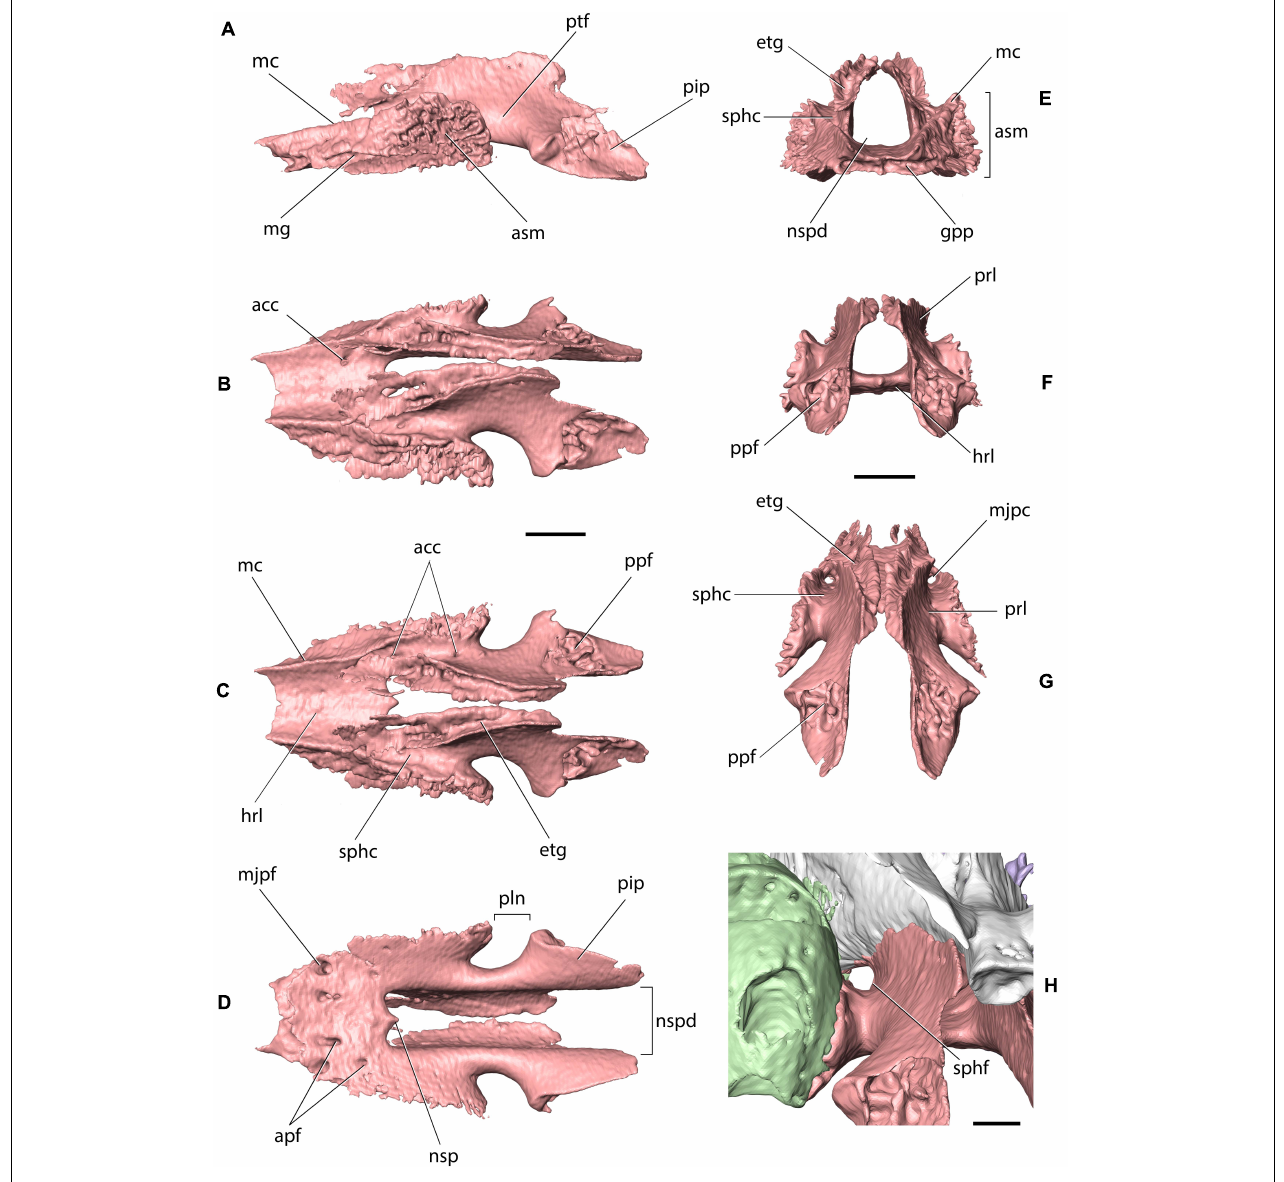
FIGURE 7 | Palatine of Palaeolagus haydeni (FMNH PM9476) in (A) left lateral, (B) left dorsolateral, (C) dorsal, (D ) ventral, (E) anterior, (F) posterior, (G) posterodorsal, and (H) left posterolateral views. Left maxilla shown in light green, presphenoid shown in white. acc, dorsal opening of accessory palatine canal; apf, accessory palatine foramen; asm, articular surface for alveolar process of maxilla; etg, ethmoidal groove; gpp, groove for palatine process of maxilla; hrl, horizontal lamina; mc, maxillary crest; mg, maxillary groove; mjpc, major palatine canal; mjpf, major palatine foramen; nsp, nasal spine; nspd, nasopharyngeal duct; pip, pyramidal process; pln, palatine notch; ppf, fissure for pterygoid process of basisphenoid; prl, perpendicular lamina; ptf, pterygopalatine fossa; sphc, sphenopalatine canal; sphf, sphenopalatine foramen. Scale bars for (A–G) = 2 mm, scale bar for (E) = 1